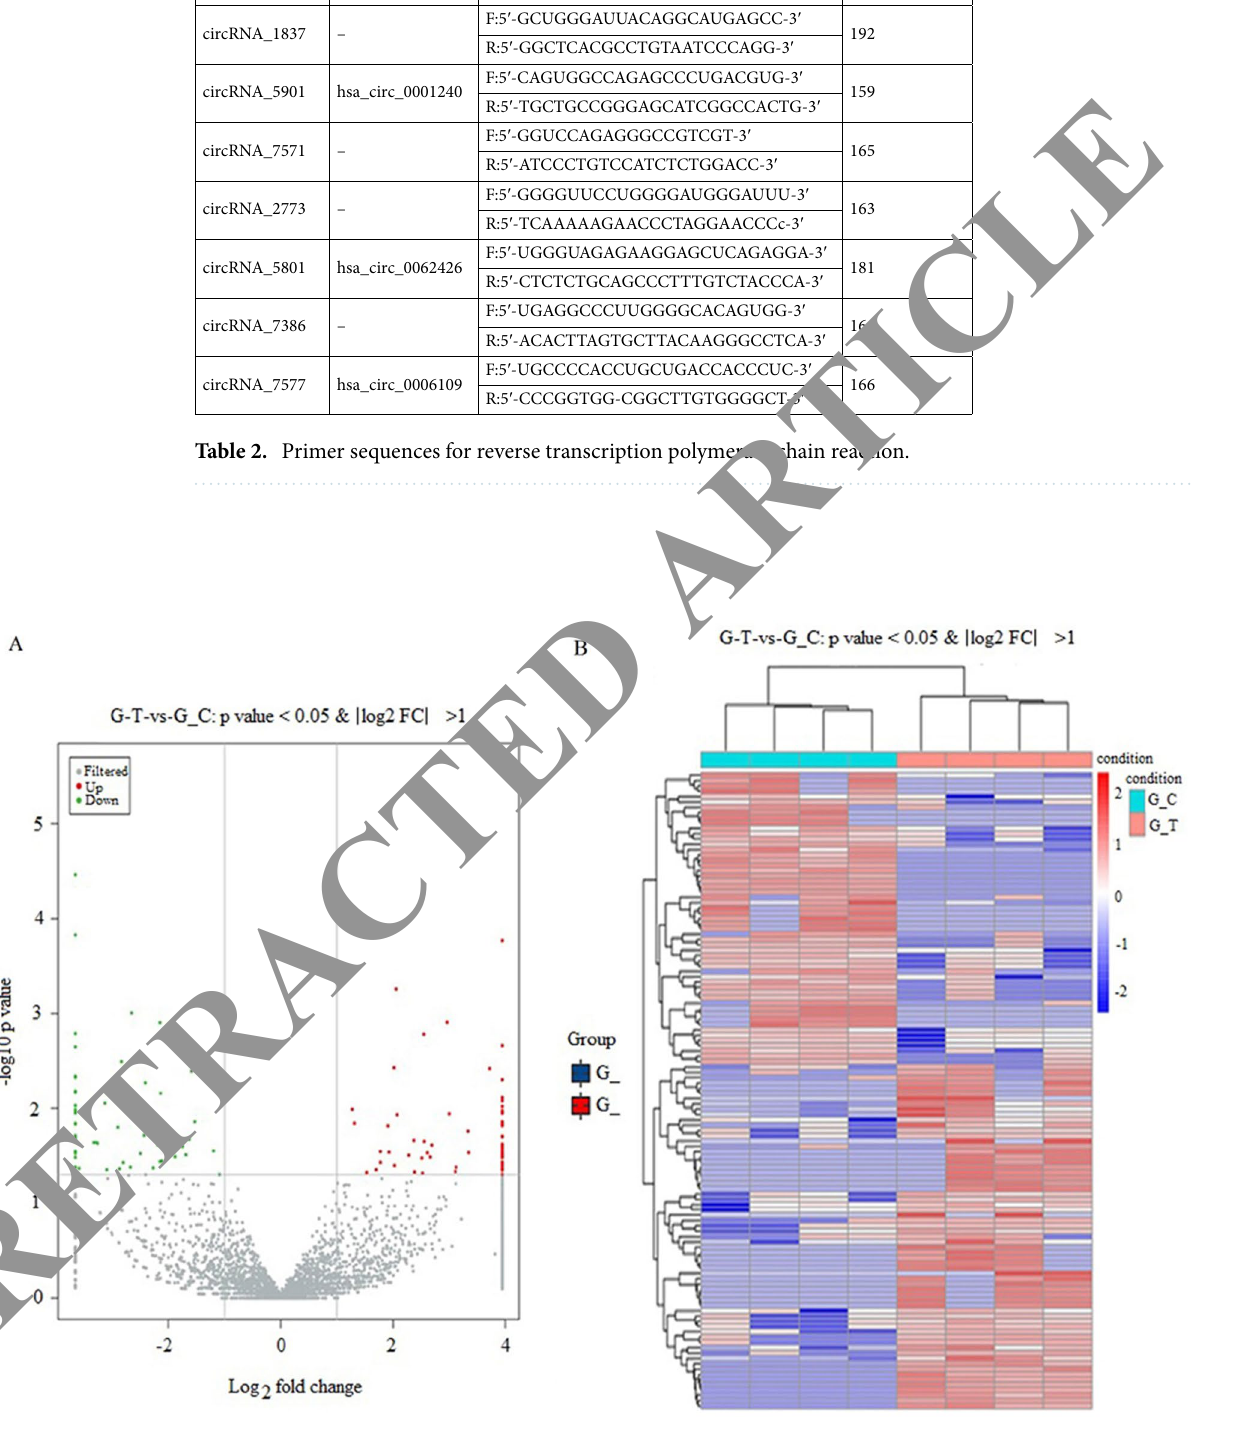
Figure 1. Differentially expressed circRNAs between AF group and control group. ( A ) Volcano plots are displayed for visualizing the differential expression of circRNAs. The red and green points in the plot represent the differentially expressed circRNAs with statistical significance. ( B ) Hierarchical cluster analysis of all the deregulated